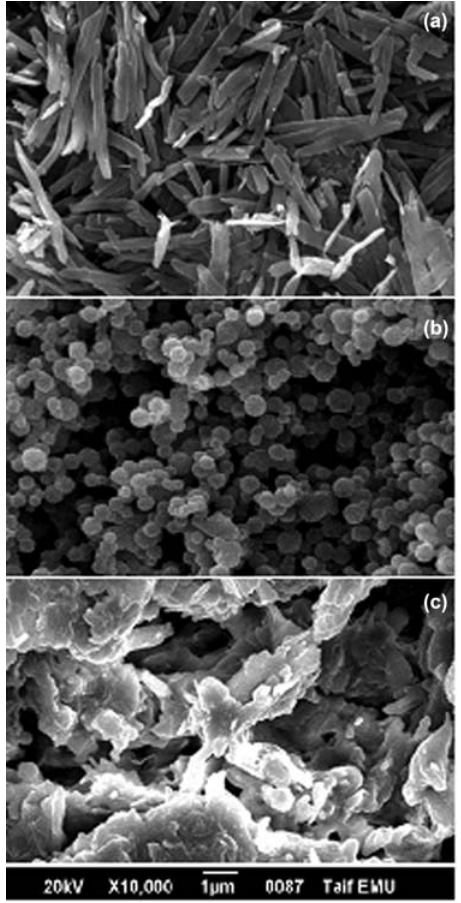
Figure 2: SEM micrographs of ( a ) AgStNPs, ( b ) bare organic monolith, and ( c ) AgStNP – methacrylate polymeric